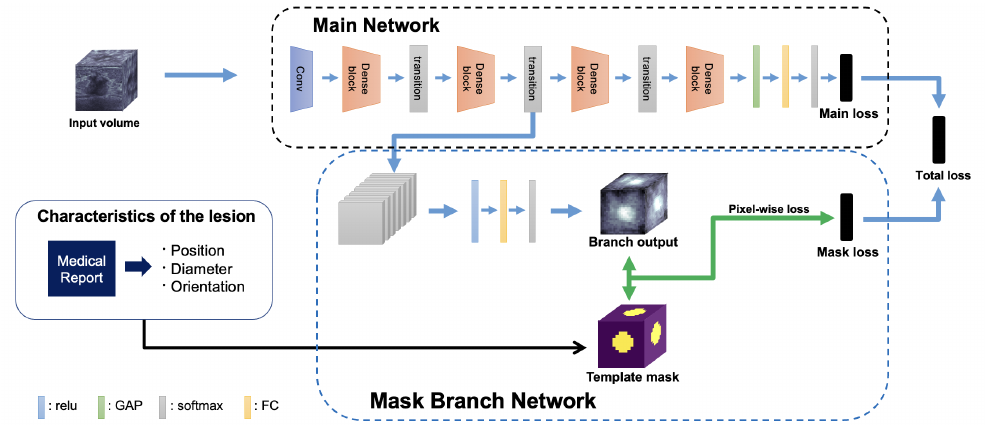
Figure 2. The architecture of our proposed network: mask branch network. Mask branch network is integrated into main network, helping the main network focus on where the lesions exist. Mask branch network learns spatial information from the template mask generated from charateristics of the